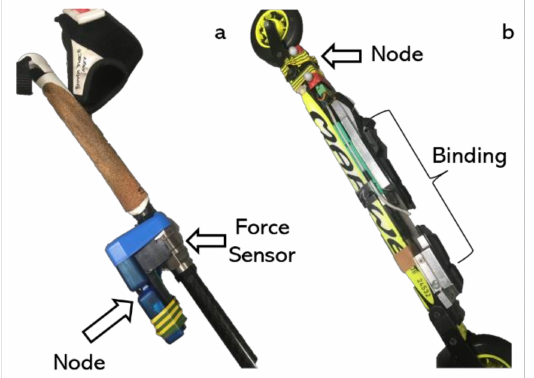
Figure 1. Equipment used in this study: ( a ) Pole force measurement sensor. ( b ) Force measurement